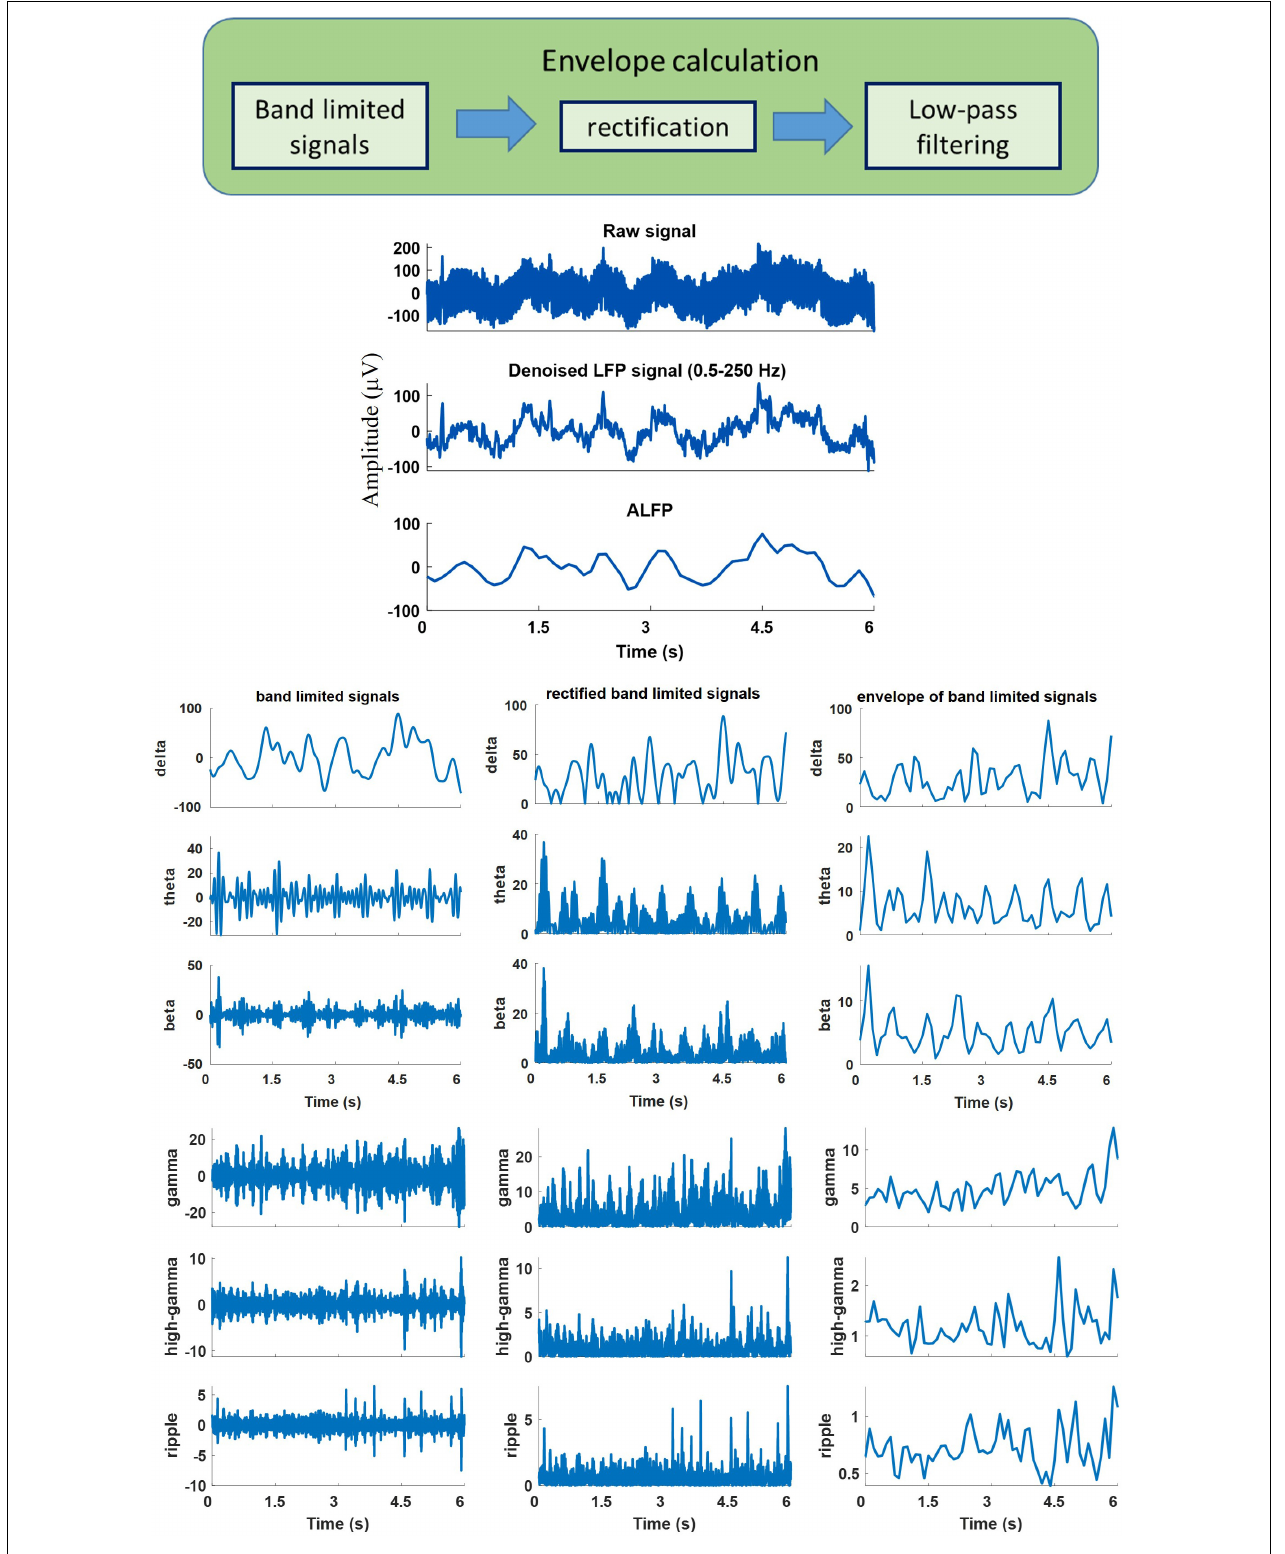
FIGURE 4 | An example of the recorded raw signal, corresponding extracted local field potential (LFP), extracted band-limited signals at different frequency bands, corresponding rectified signals, and their envelopes.